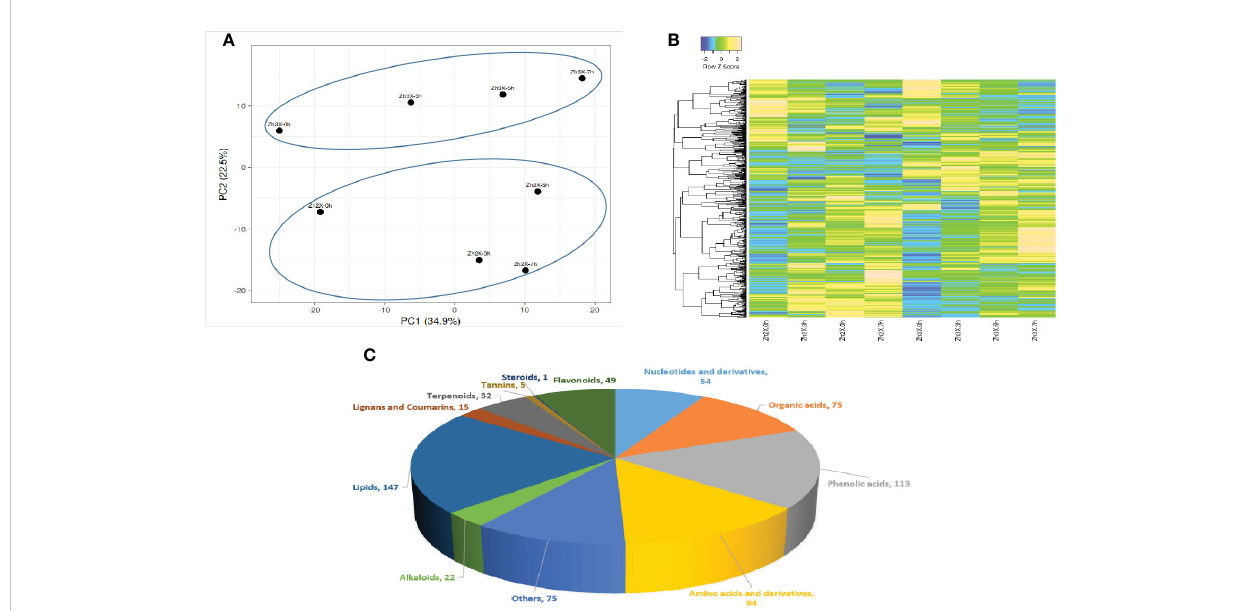
FIGURE 7 Cataloguing of metabolites in 2X and 3X watermelon leaves under fl ooding stress. (A) PCA plot presenting metabolic variations in 2X and 3X watermelon leaves at different days post fl ooding. (B) Heatmap illustrating metabolic contents among 2X and 3X watermelon leaves under fl ooding stress. (C) Detected metabolites are categorized into diverse groups on annotation basis.